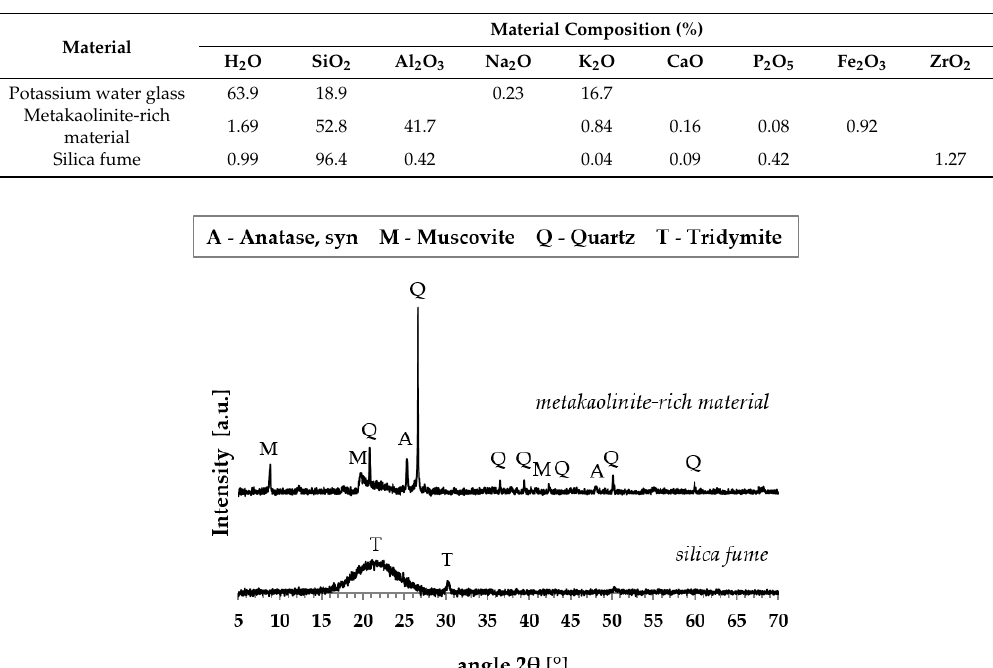
Table 1. Chemical composition of raw materials.